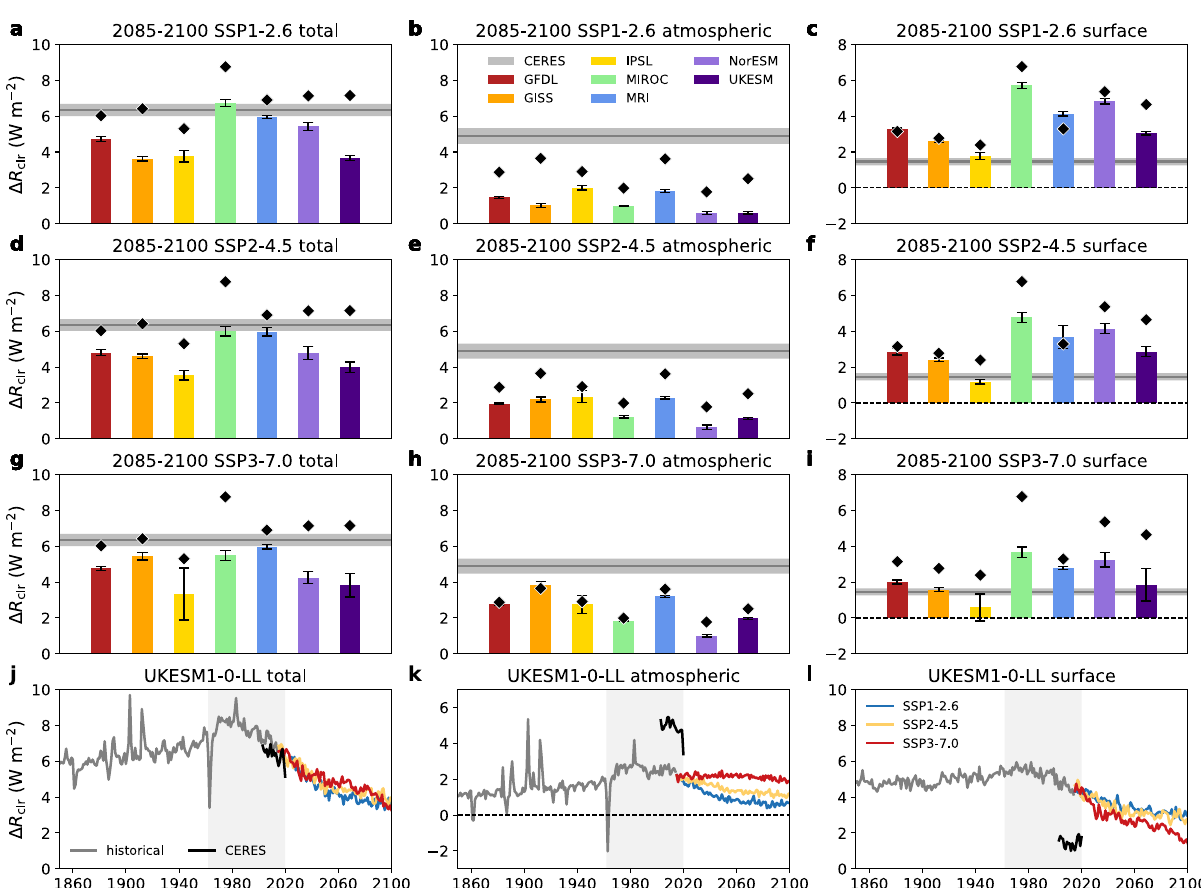
Fig. 4 Clear-sky hemispheric albedo asymmetry changes in CMIP6 runs of future scenarios. a – i As in Fig. 2d – i, but for the SSP1-2.6 ( a – c ), SSP2-4.5 ( d – f ), and SSP3-7.0 ( g – i ) runs. j – l Example time-series of historical (gray lines), SSP1-2.6 (blue lines), SSP2-4.5 (yellow lines), and SSP3-7.0 (red lines) total ( j ), atmospheric ( k ), and surface ( l ) re fl ection asymmetries ( Δ R clr ) from the UKESM1-0-LL model and observed CERES mean values (black lines). Light gray shading in j – l represents the time period in which reliable space-based estimates of Earth ’ s albedo have been